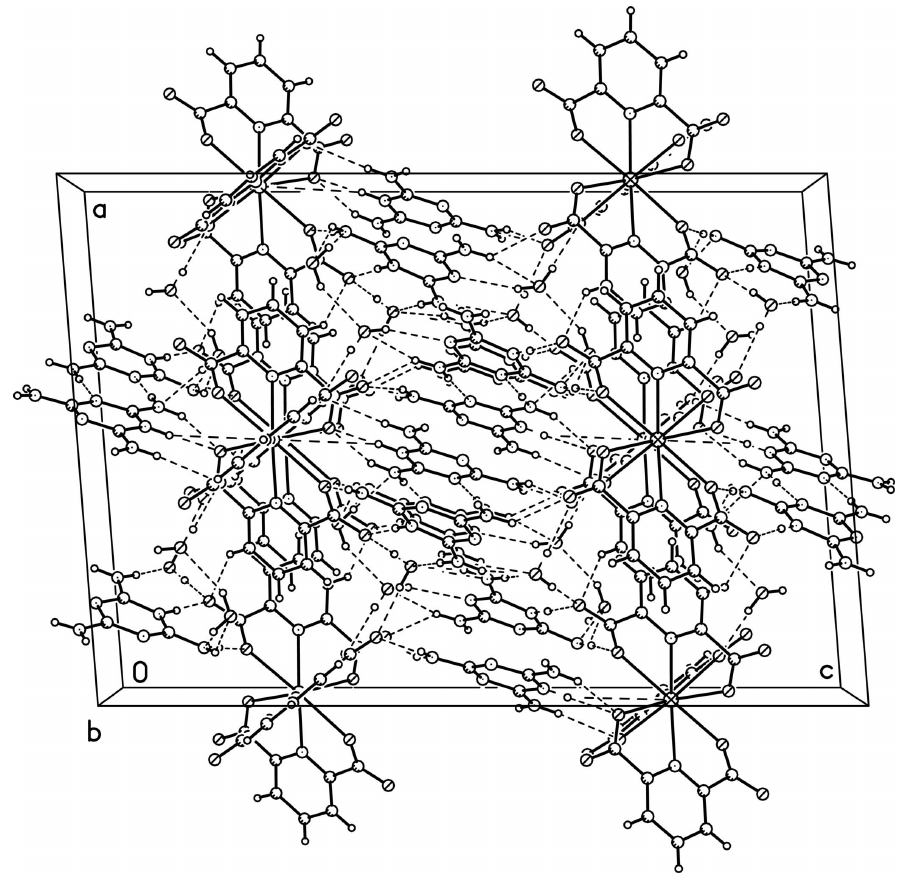
Figure 3 Crystal packing with hydrogen bonds shown as dashed lines. Tetrakis(2,4,6-triamino-1,3,5-triazin-1-ium) tris(pyridine-2,6-dicarboxylato)calcate(II) hexahydrate Crystal